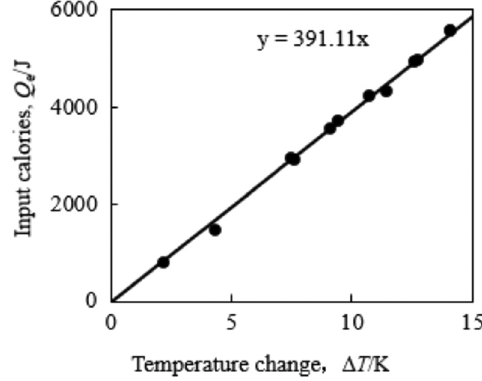
Figure 4: Amount of heat input by the power supply and temperature